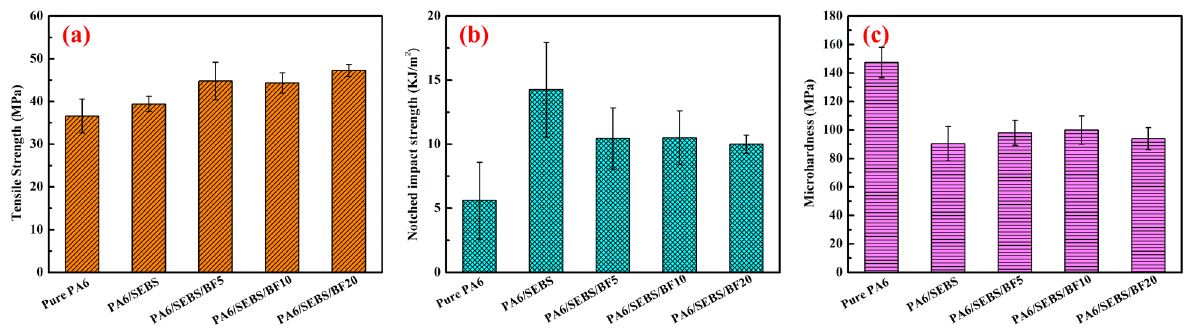
Figure 5. ( a ) Tensile strength, ( b ) notched impact strength, and ( c ) microhardness of neat PA 6, PA 6/SEBS blend, and PA 6/SEBS/BF